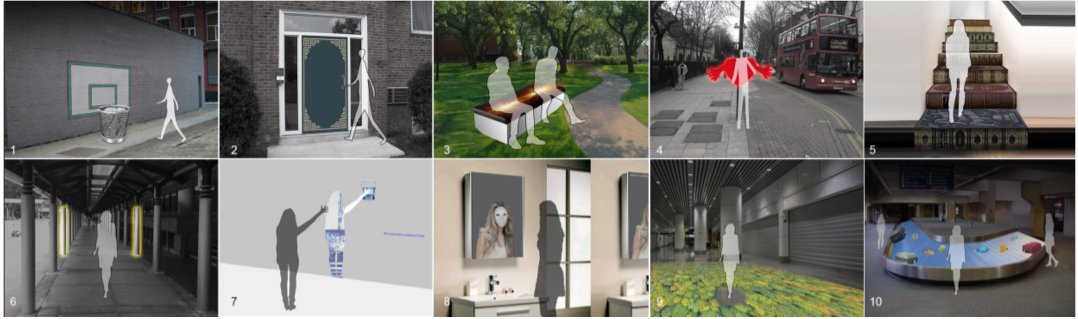
Figure 5. Design